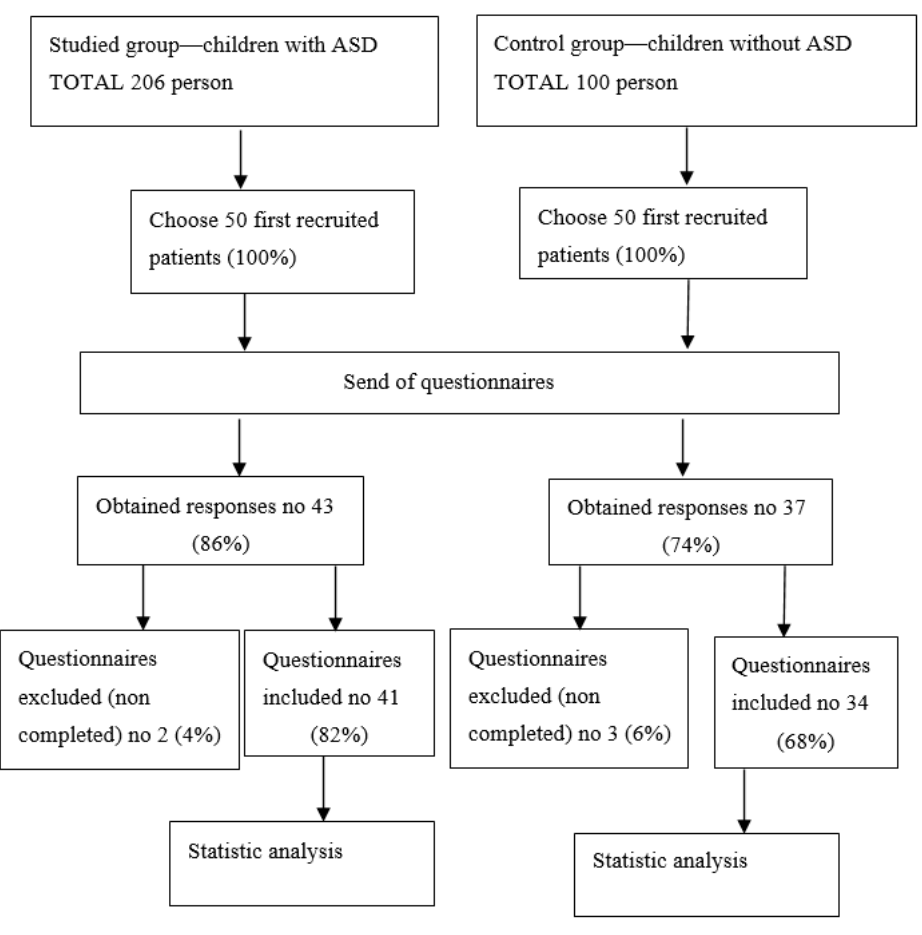
Figure 1. Study flow diagram. Table 1. Distribution of sex in the study group and the control group.